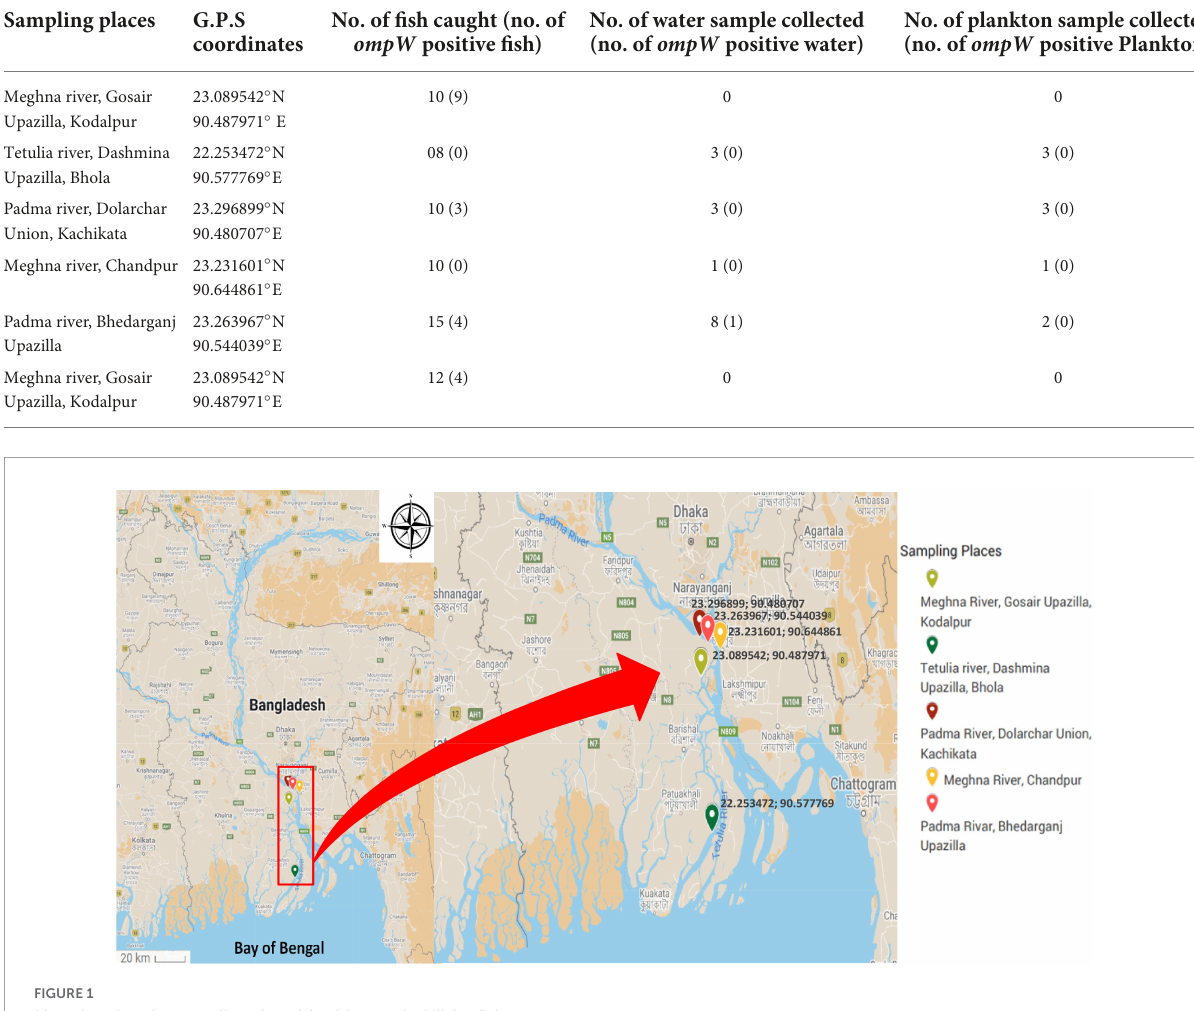
for each of the strains and biofilm formation by isolates was calculated and categorized according to the absorbance (Samadi et al.,